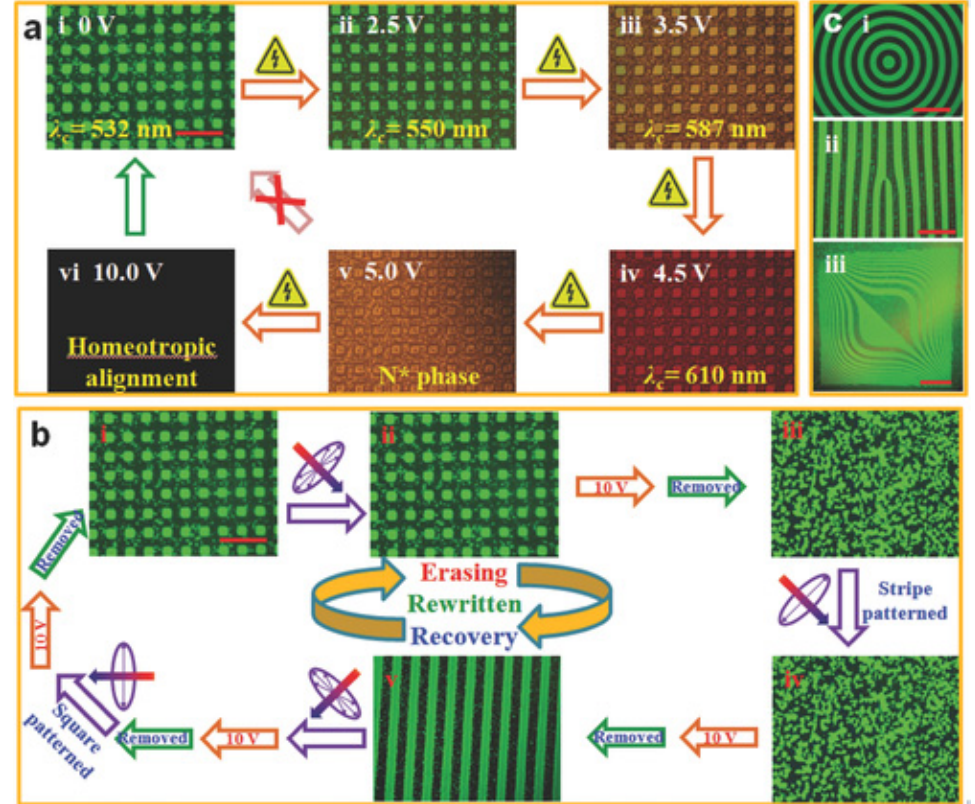
Figure 11. Stimulus orientation behavior of crystal orientation patterns formed by alternating uniform and random BP domains. ( a ) The BP lattice can be deformed by an applied voltage, leading to a red-shifting of the central wavelength of reflection band. ( b ) The pattern can be erased and rewritten by sequential UV-irradiation and electric-field stimulation. ( c ) Another different regular periodic patterns and irregular topological patterns can be rewritten [104]. Light-Patterned Crystallographic Direction of a Self-Organized 3D Soft Photonic Crystal from Zheng, Adv Mater, published by John Wiley and